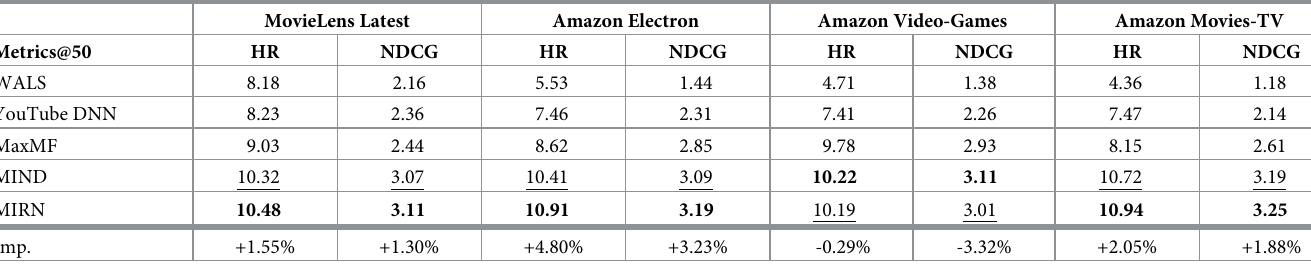
Table 3. Performance comparison of different models on publicly available datasets.